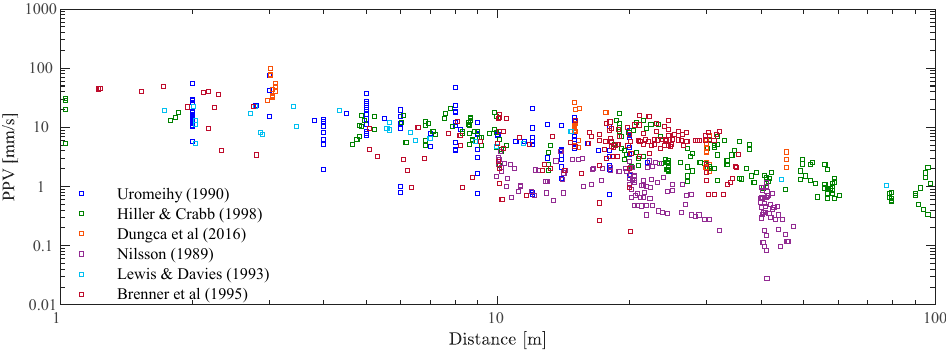
Figure 14. Systematization of the experimental measurements of vibrations induced by impact pile driving reported in the literature.